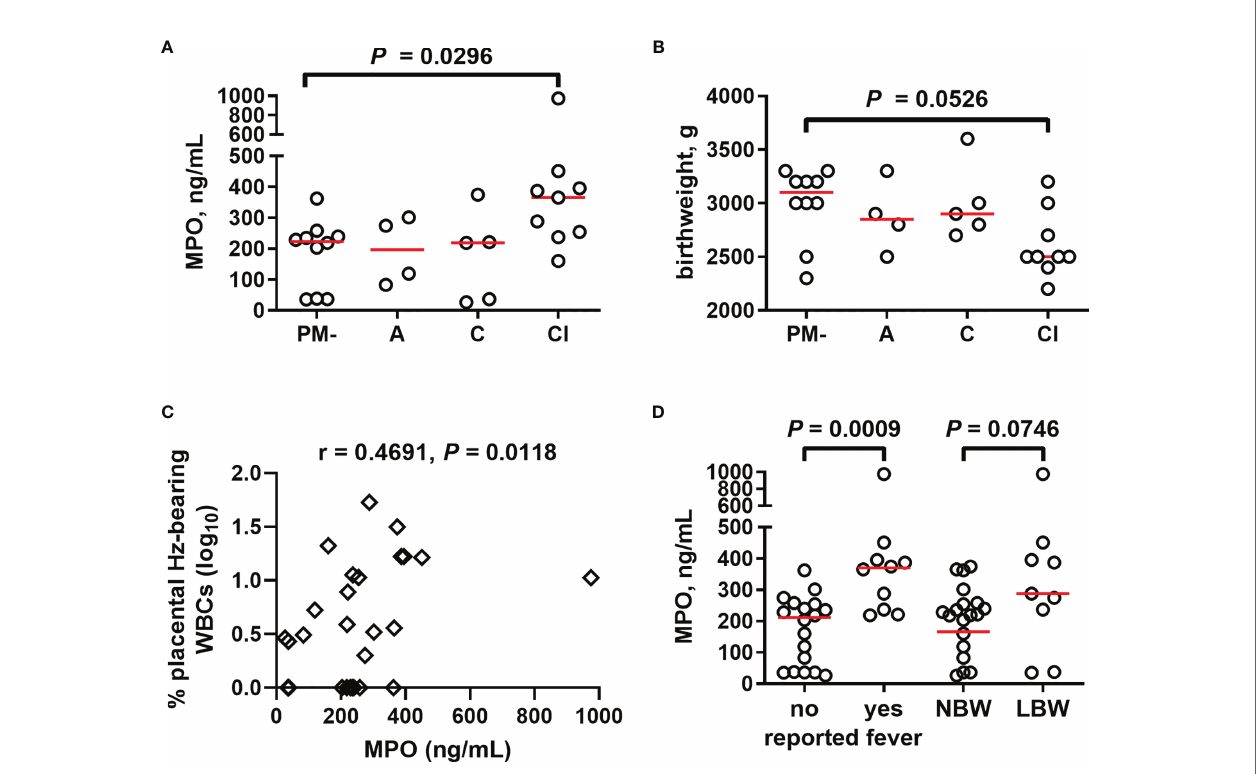
FIGURE 4 | Placentalblood MPO levelsincrease inchronic, in fl ammatoryplacentalmalaria, together with reduced birth weight. (A) MPO measured inplacental plasma by ELISA fromprimigravid women with and withoutPMstrati fi ed by placental histopathological status(see Methods). (B) Infant birth weightfromthe same women issimilarly strati fi ed. (C) MPO levelscollectivelyanalyzed by Spearman ’ s correlation test with percent placental leukocytes (WBCs) bearingengulfed hemozoin. (D) Placental MPO levels measured byELISA assessed for relationshipswith self-reportedfever and infant birth weight. Statistics by Kruskal-Wallistest with post-hoc group-wise comparisons by Dunn ’ s multiple comparisonstest. PM- = placental malaria negative (n= 10);A = acute infection (n = 4);C = chronic infection (n = 5); CI = chronic in fl ammatoryinfection (n = 9); NBW= normal birth weight (n = 19); LBW = low birth weight (n = 9);noself-reported fever (n = 18), reportedfever (n=